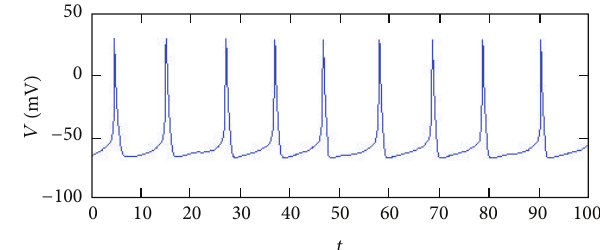
= 0.1 . AMPA Figure 7: Membrane potential of a MC when 𝑔